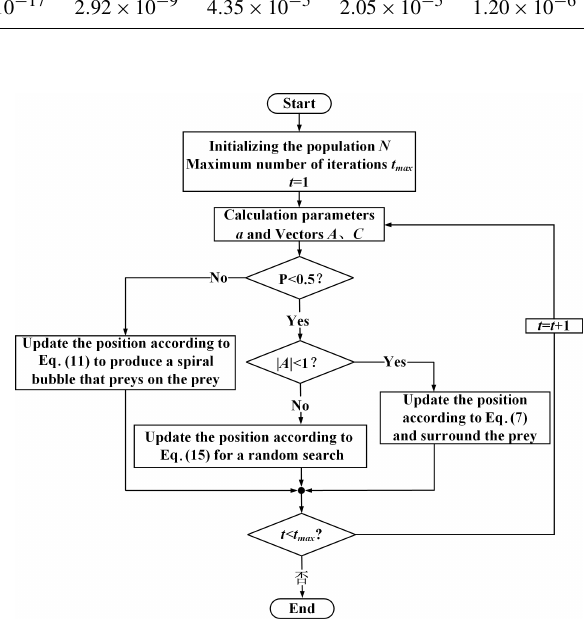
Figure 15. Calculation flow